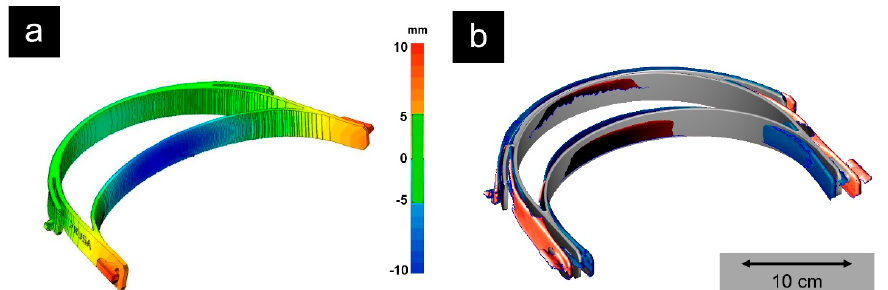
Figure 5. The predicted deformation by simulation after the 3D printing process based on the original geometry ( a ). 3D scan of the printed medical-grade polypropylene headbands based on the original Prusa templates (red) and based on the optimized template (blue) in comparison to the original STL file (grey) ( b ). The optimized headbands exhibited a better fit by compensating for the warpage and could be printed in large numbers without faulty rejects due to the process optimization.